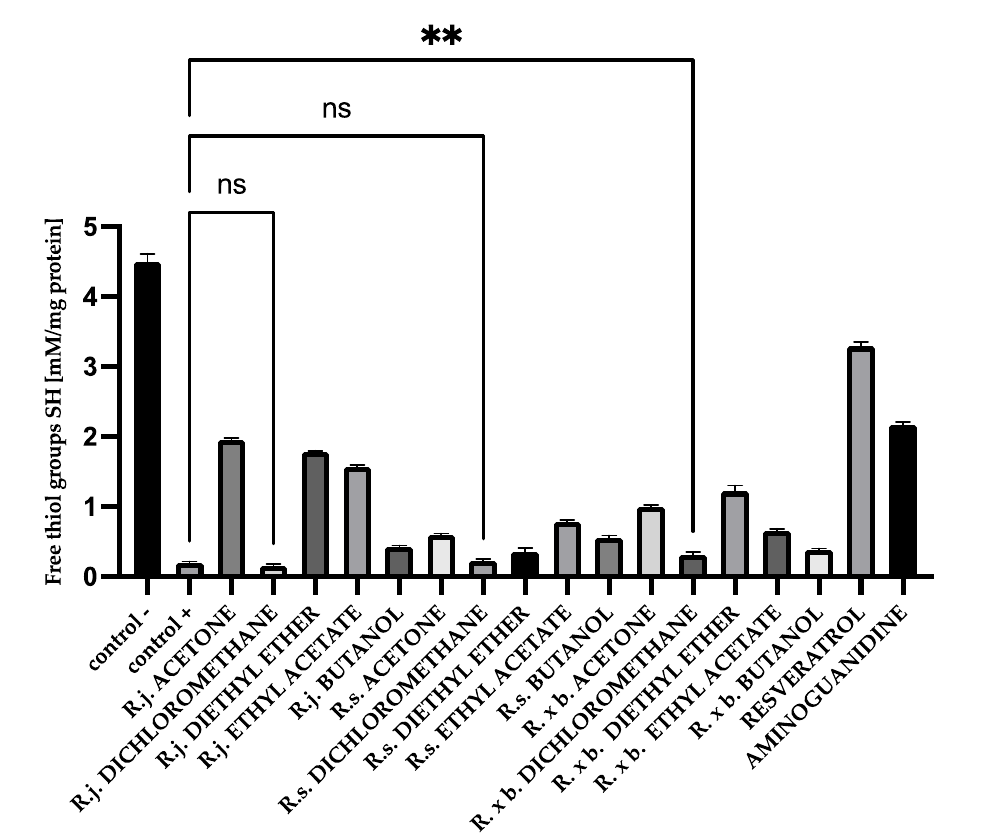
Figure 8. The effect of extracts and fractions on the in vitro formation of SH groups in BSA glycation. R.j., R.s., and R. × b. mean Reynoutria japonica , Reynoutria sachalinensis , and Reynoutria × bohemica , respectively. Error bars shown in this figure are means ± SD for n ≥ 5. ** Statistically significant at p ≤ 0.01 compared to control; ns—not statistically significant at p ≤ 0.05. All other results are statistically significant at p ≤ 0.0001 compared to control +. Detailed information can be found in the Supplementary Materials.